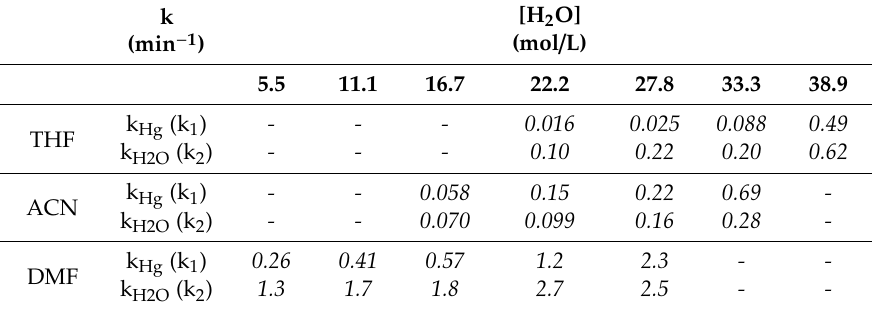
= 1.2 × 10 − 3 mol / L and 2 ]